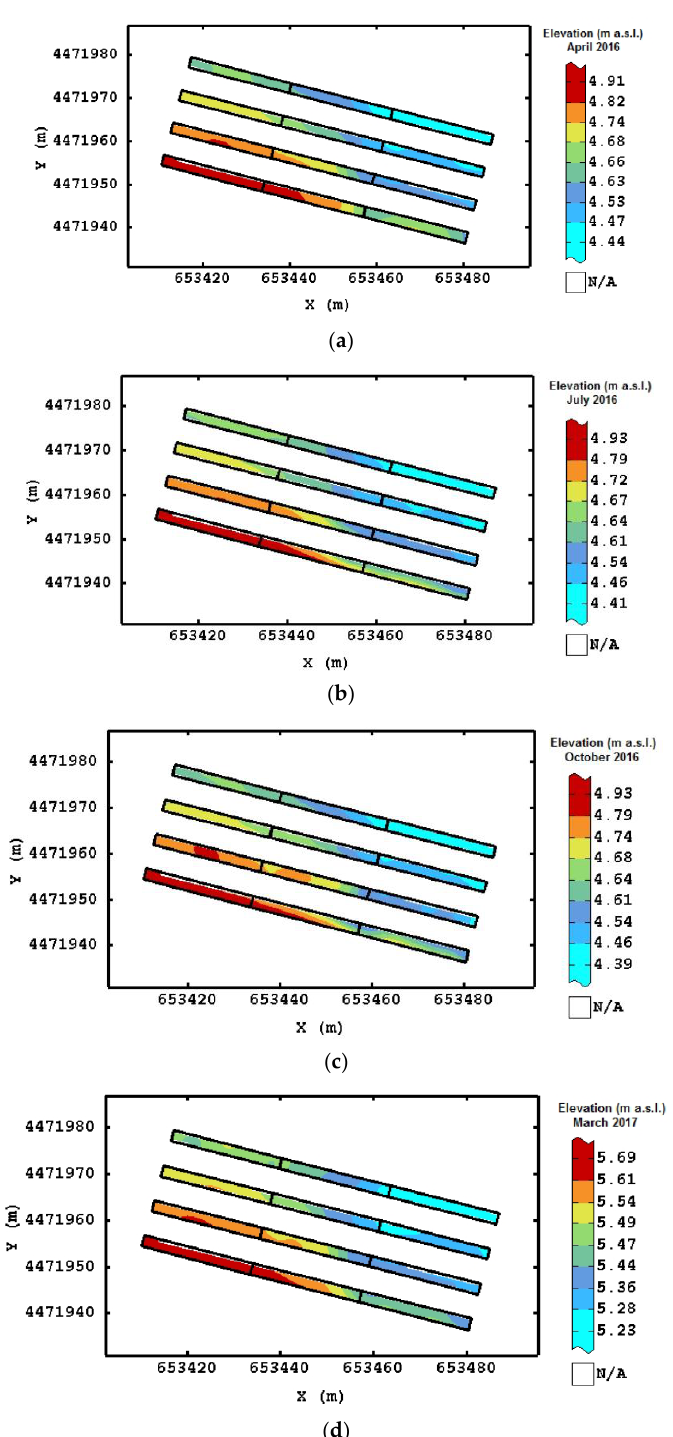
Figure 8. Spatial estimate of elevation in April 2016 ( a ); July 2016 ( b ); October 2016 ( c ) and March 2017 ( d ). Color scale uses iso-frequency classes.